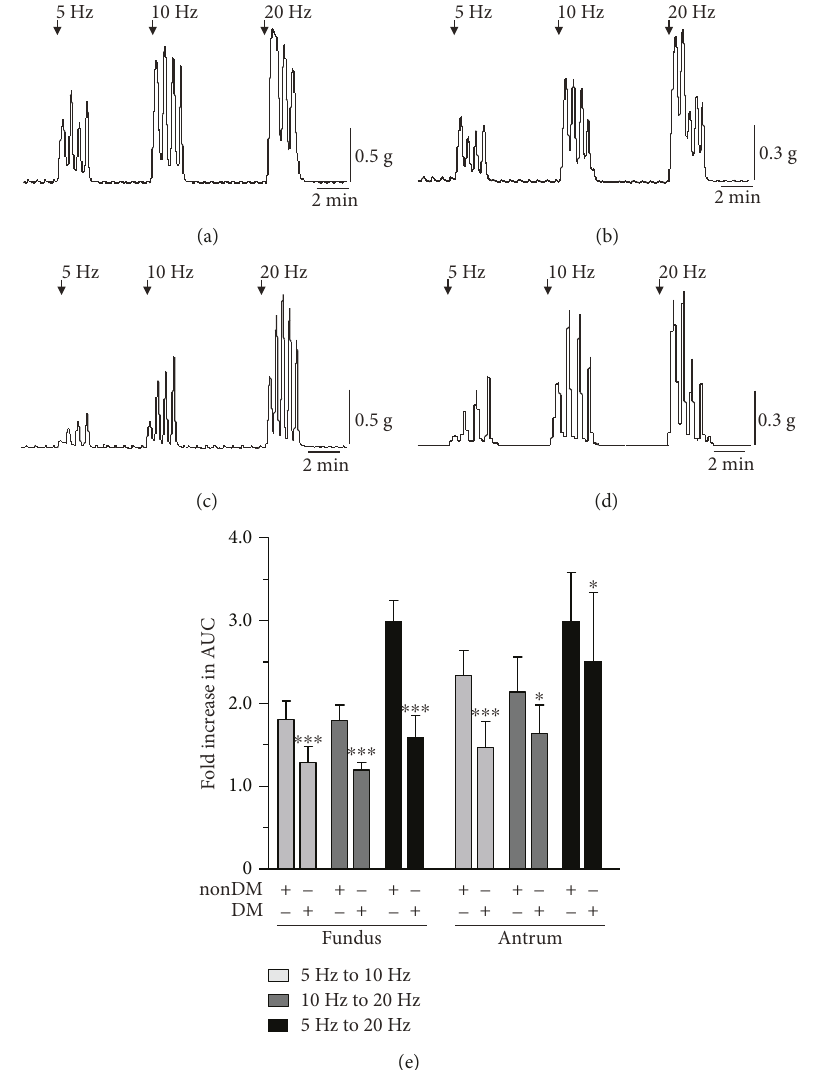
Figure 7: Contractile responses of nondiabetic and diabetic gastric fundus and antrum muscles to cholinergic motor neuron stimulation. Representative traces of the contractile responses of muscle strips to 5 Hz, 10Hz, and 20 Hz EFS from (a) nondiabetic and (b) diabetic fundus muscles and (c) nondiabetic and (d) diabetic antrum muscles. (e) Mean fold increase in AUC ± SD of nondiabetic and diabetic fundus and antrum muscles stimulated with 5 Hz, 10 Hz, or 20Hz EFS ( n = 9 ). ∗ P < 0 05 and ∗∗∗ P < 0 0001